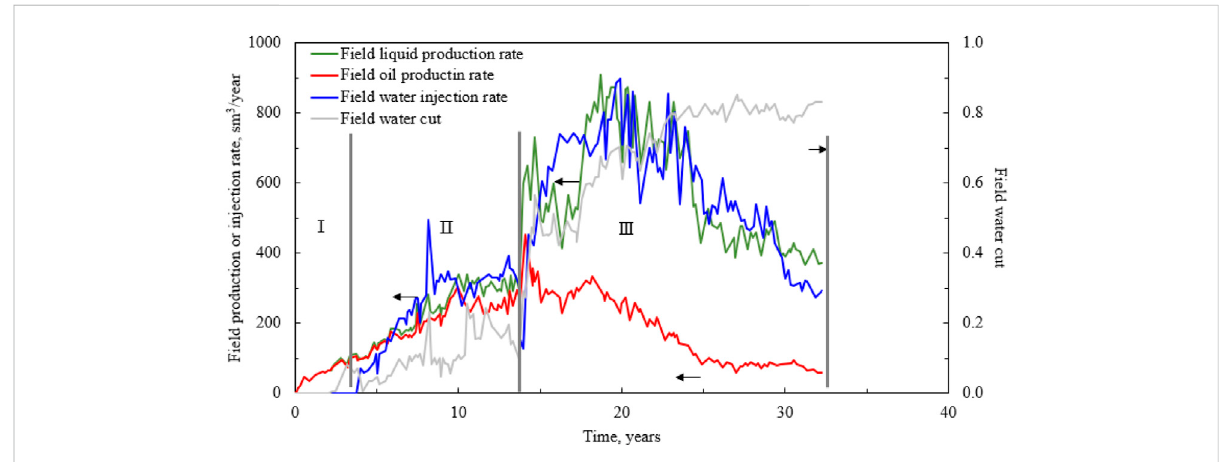
FIGURE 7 Production history curves of Bin8-3 unit in Shengli Oil fi eld (China).